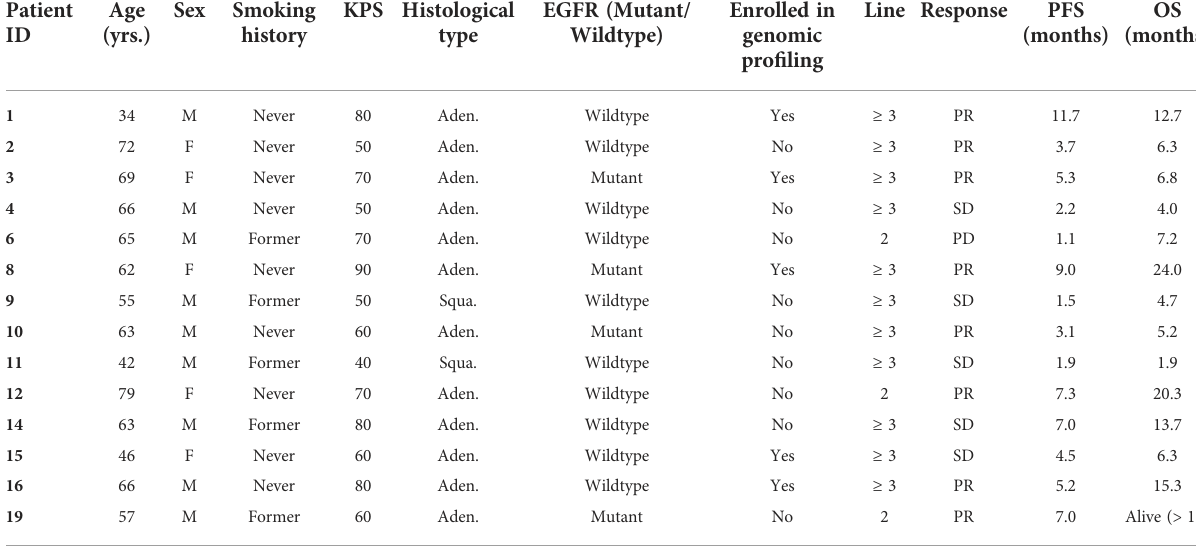
TABLE 2 Clinical characteristics and outcome of 14 patients treated with anlotinib.